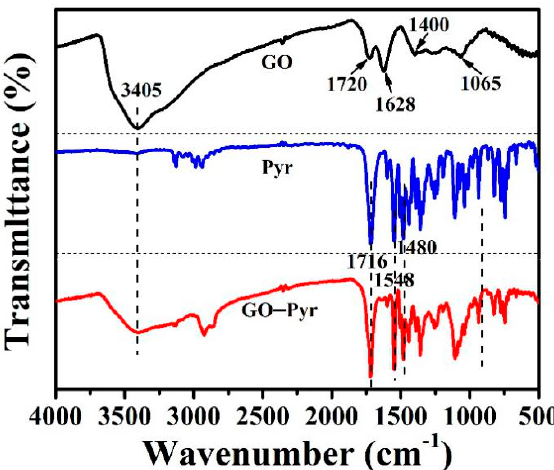
Figure 2. FT–IR spectra of GO, Pyr and GO–Pyr.